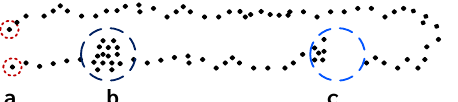
Algorithm 1. Stop Point Extraction (TDBC)